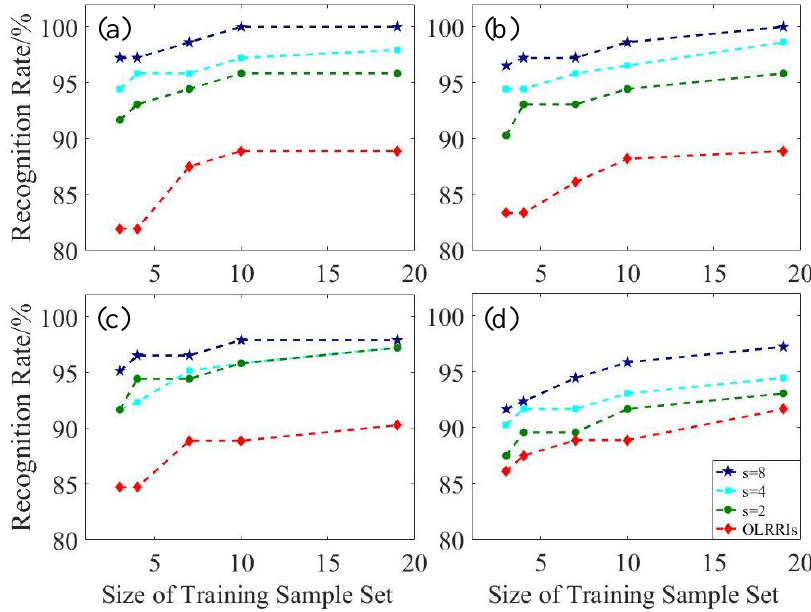
Figure 10. Comparison of the recognition rate of the multi-res training sample set with the multi-res test sample set without noise. The resolution of the training sample set was ( a ) OHRRI. ( b ) Down-sampled image of OHRRI by factor 𝑑 of 2. ( c ) Down-sampled image of OHRRI by factor 𝑑 of 4. ( d ) Down-sampled image of OHRRI by factor 𝑑 of 8 (i.e., OLRRI).